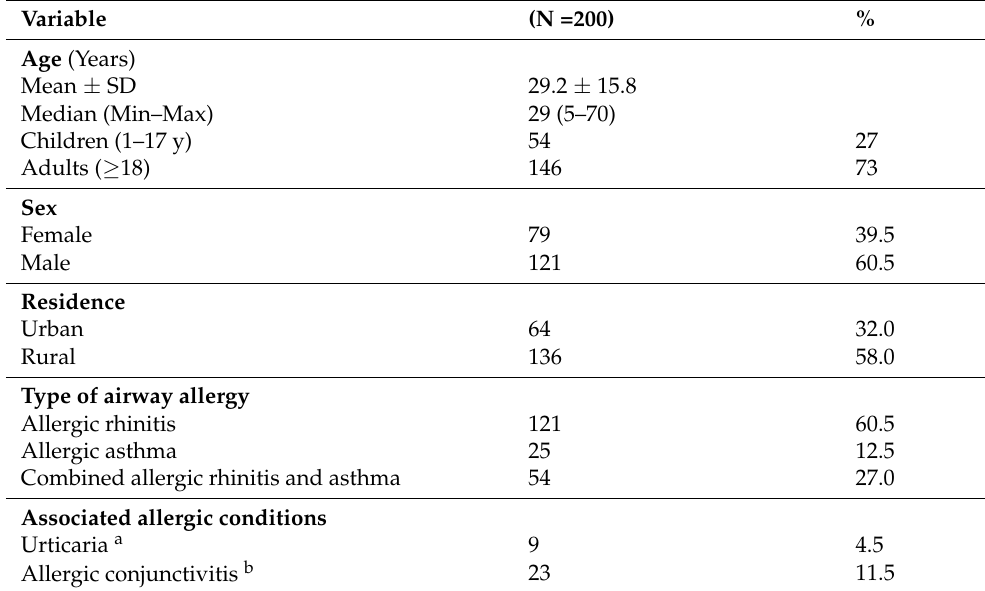
Table 1. Sociodemographic and clinical characteristics of the studied